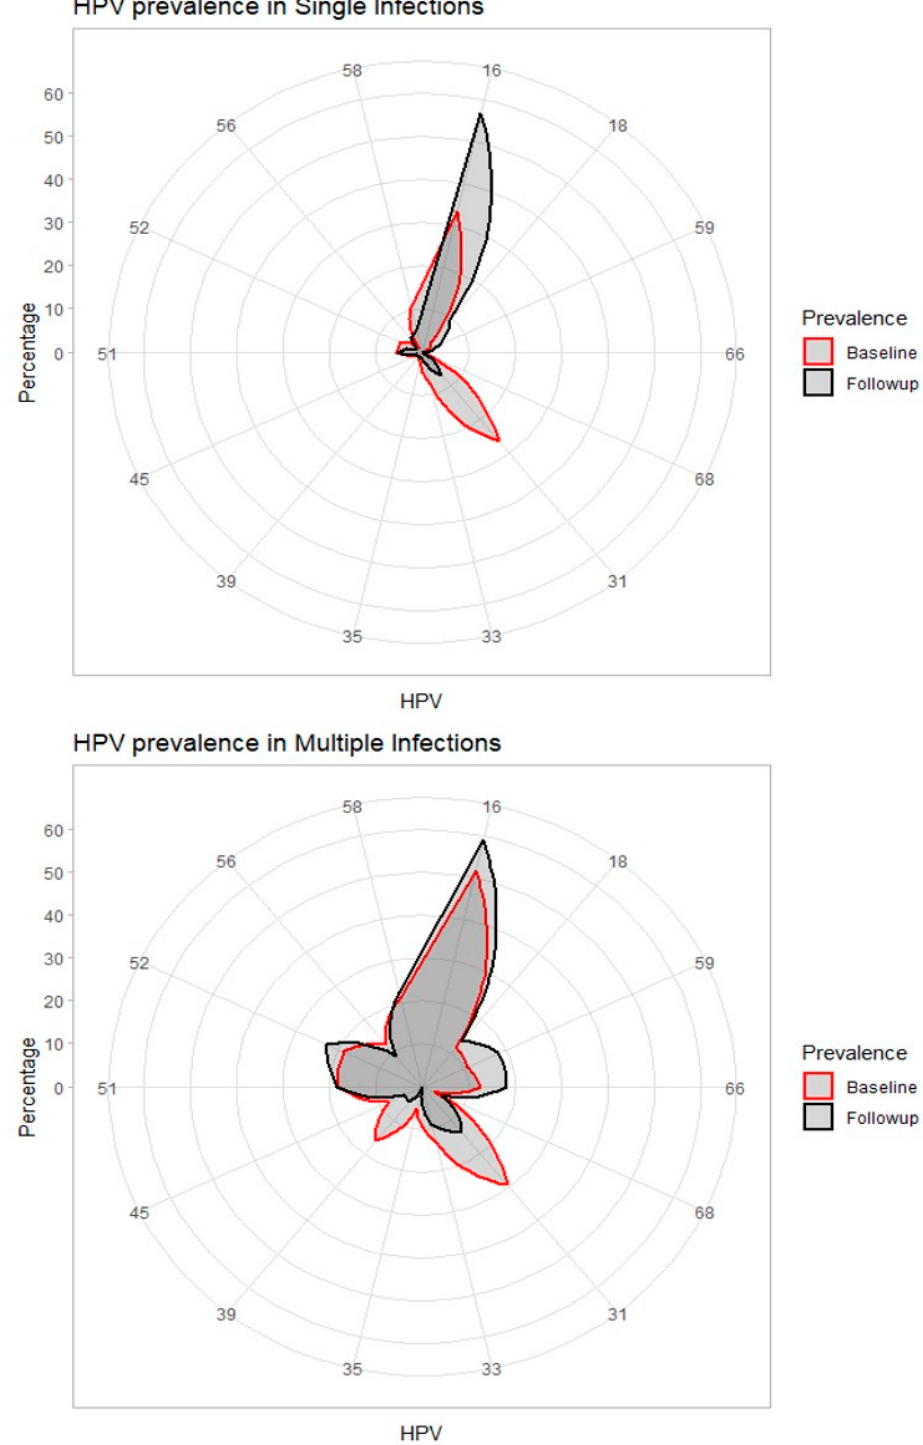
Figure 2. High-Risk Genotypes distribution at baseline and at 3–9 months follow-up visit. Overall, 21 (5.1%) patients relapsed within two years from the first follow-up visit and the overall two-year CIF was 8.6% (95% CI: 5.1–13.2%) (Table 3).